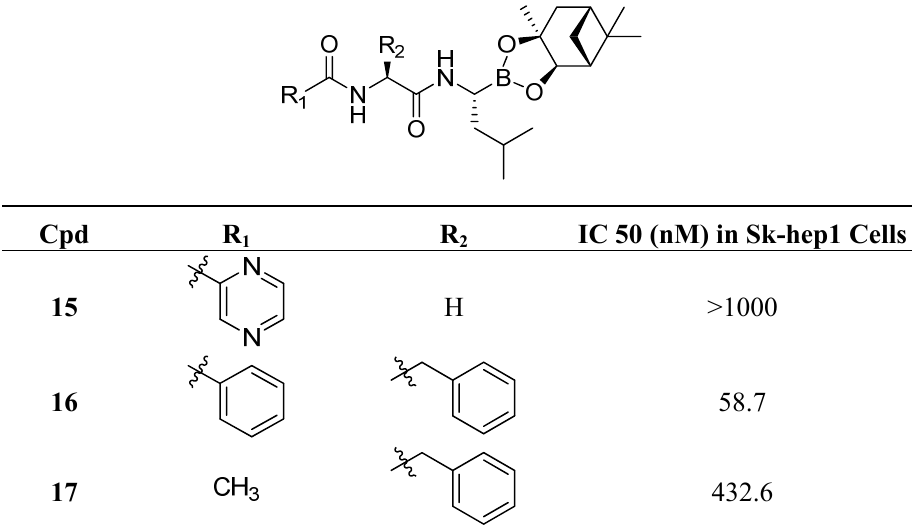
Table 2. Chemical structure of synthetized compounds and IC